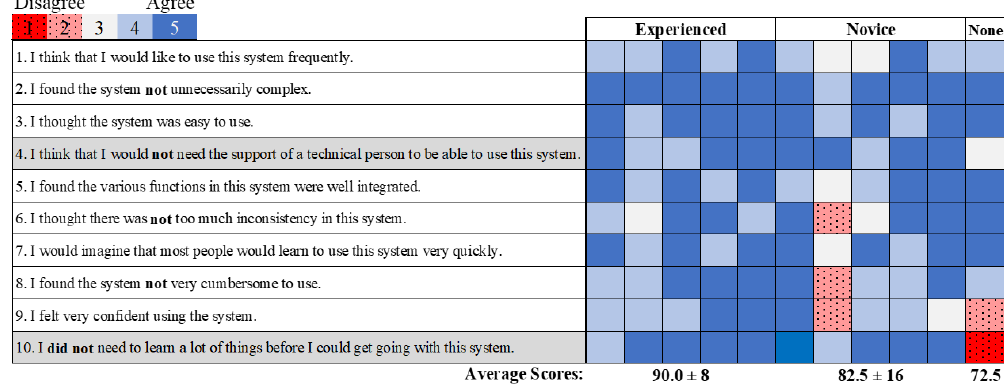
Figure 13. System usability survey scores separated by participant (n = 11). Average scores are separated by video-game experience (experienced, novice, none). The survey items highlighted in gray are specifically associated with learnability. The survey statements were converted to the positive direction (changes in bold font) to be consistent with scoring and facilitate the interpretation of the figure.